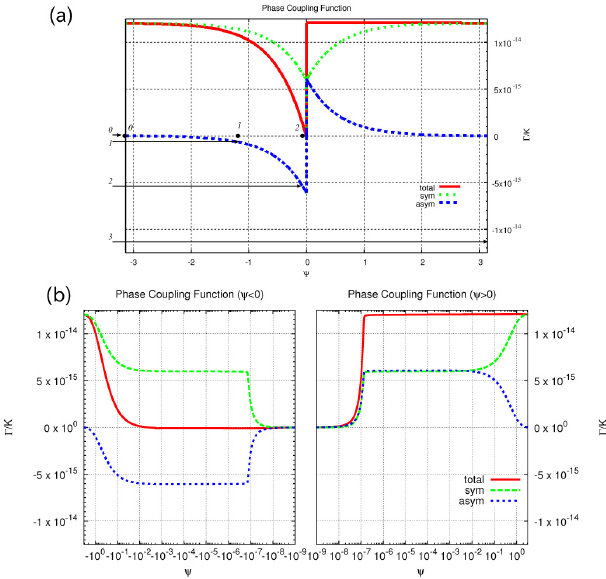
Fig. 10. The phase coupling function, ˆ 0 , as a function of phase, nor- malised by the coupling intensity K = k 12 = k 21 , in (a) linear scale of ψ and (b) logarithmic scales of ψ . The parameters are set to ( k,V p ,g,A,B,L) = (1 . 00 × 10 5 Nm − 3 , 3 . 17 × 10 − 9 ms − 1 , 5 . 00 × 10 6 Nm − 3 s, 1 . 50 × 10 5 Nm − 2 , 2 . 20 × 10 5 Nm − 2 , 1 . 00 × 10 − 2 m). The blue, green, and red curves are the antisymmetric part ˆ 0 a , sym- metric part ˆ 0 s , and total ˆ 0 , respectively. For each case in Table 1, the phase difference ψ of synchronized oscillators and the corre- sponding value of − 1ω/( 2 K) are indicated by a filled circle and an arrow,